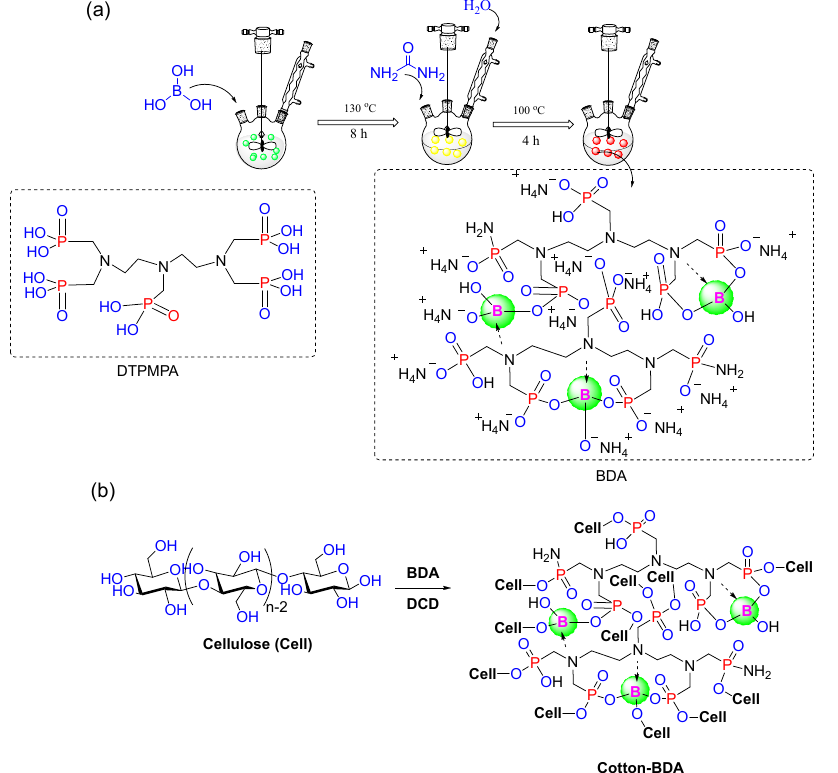
Figure 1. ( a ) Synthesis of BDA; ( b ) Proposed model of BDA interaction with cotton fiber.